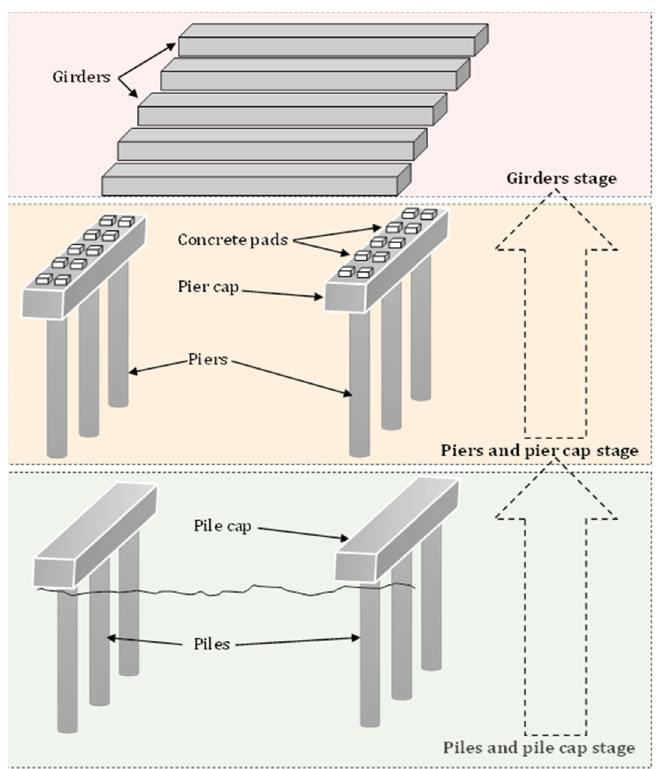
Figure 1. Key stages of bridge construction.